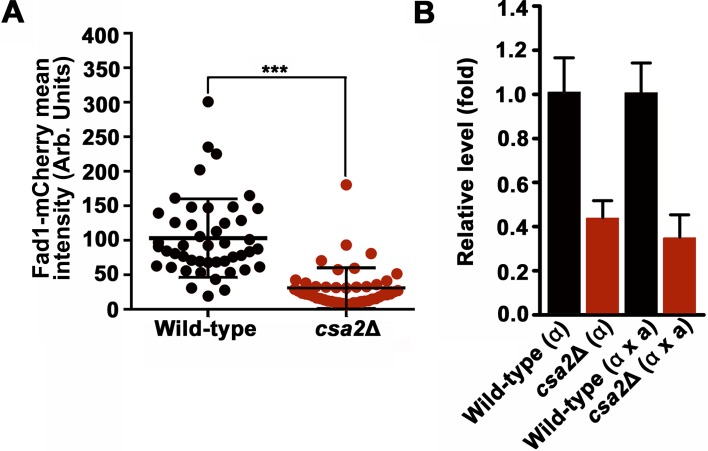
Fad1 is a downstream target of Csa2.(A) Deletion of CSA2 led to a significant reduction in the protein level of Fad1-mCherry after 7 days incubation on mating-inducing V8 medium. Asterisks indicate statistical significance calculated using a two-tailed Student’s-t test. >40 basidia were tested for each strain. (B) RT-PCR analysis showed that the FAD1 mRNA level was down-regulated in the csa2Δ mutant at 48 hr post mating induction during both unisexual and bisexual reproduction. Bars show the mean ±SD of four individual experiments.10.7554/eLife.38683.026Figure 6—figure supplement 2—source data 1.Source file for Figure 6—figure supplement 2A and B.